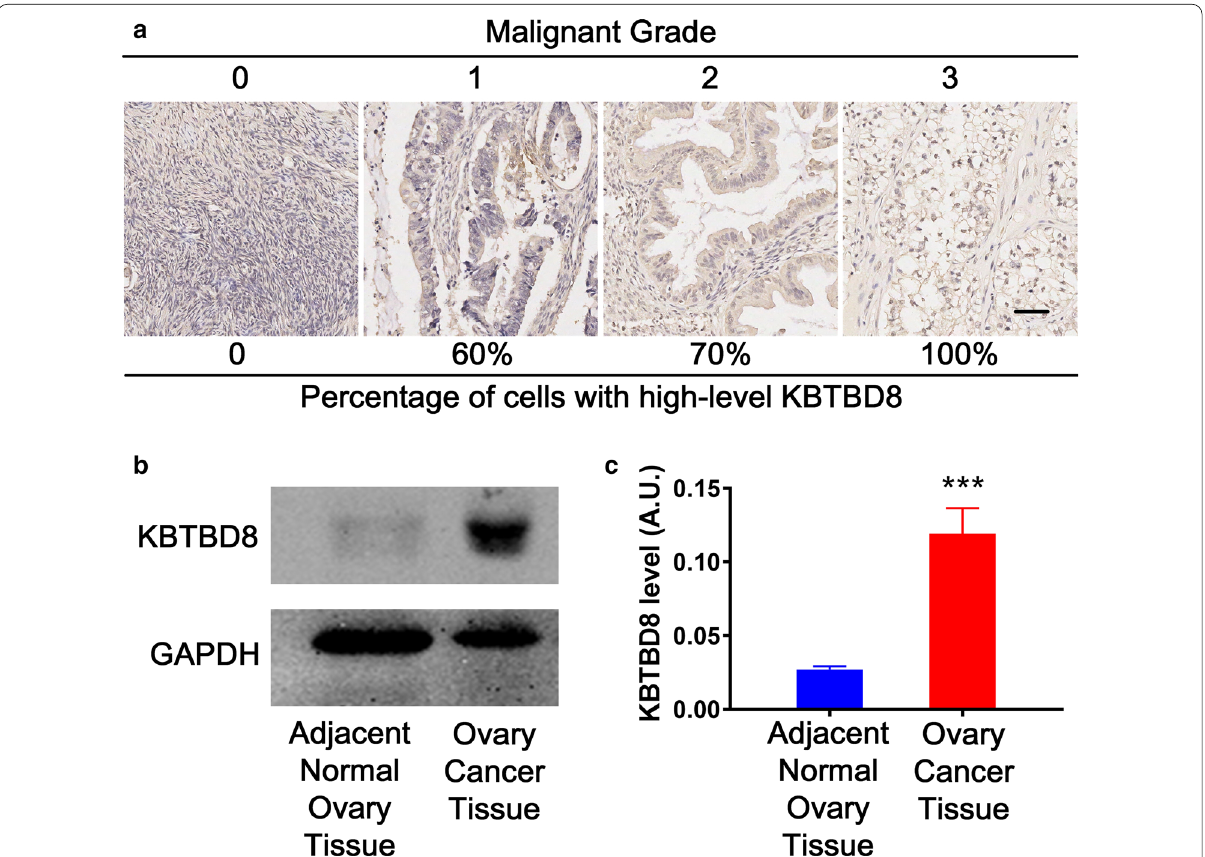
Fig. 1 Human KBTBD8 was overexpressed in multiple clinical ovarian cancer samples. a KBTBD8 immunohistochemistry on an ovary tissue microarray showed that KBTBD8 level was highly correlated with the malignancy grade of ovarian cancer (Detailed information for each array point is in Additional file 1: Dataset 1). The malignancy grade and corresponding percentage of cells with high‑level KBTBD8 are: 0 (0), 1 (60%), 2 (70%), and 3 (100%). b , c Western blot and quantification showed that the KBTBD8 protein level in ovarian cancer tissue was about fourfold higher than in adjacent normal ovarian tissue (Adjacent normal ovarian tissue vs. ovarian cancer tissue, 0.02689 vs. 0.1190). A.U., arbitrary unit. Scale bar, 100 μm. ***Indicates p <